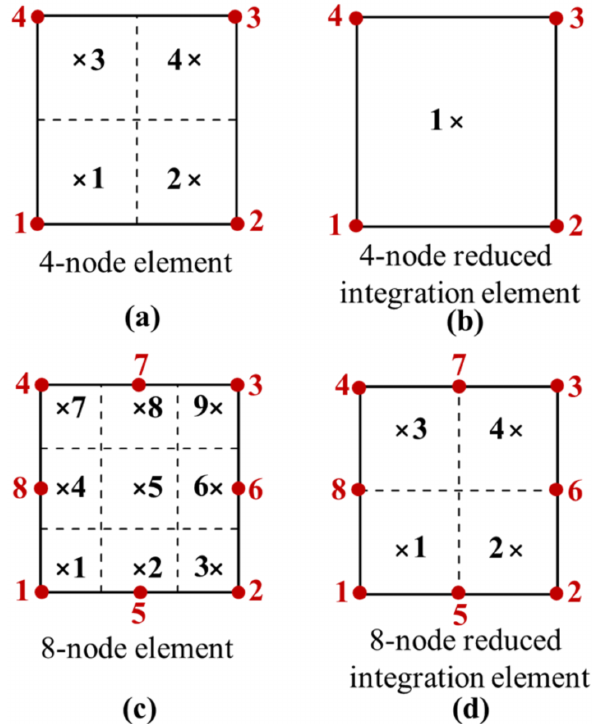
Figure 3. The numbering of integration points and nodes in 2D quadrilateral parent elements: ( a ) 4-node element, ( b ) 4-node reduced integration element, ( c ) 8-node element, and ( d ) 8-node reduced integration element. The dashed lines divide the element into integration point domains. The red dot and black cross represent the node and integration point,